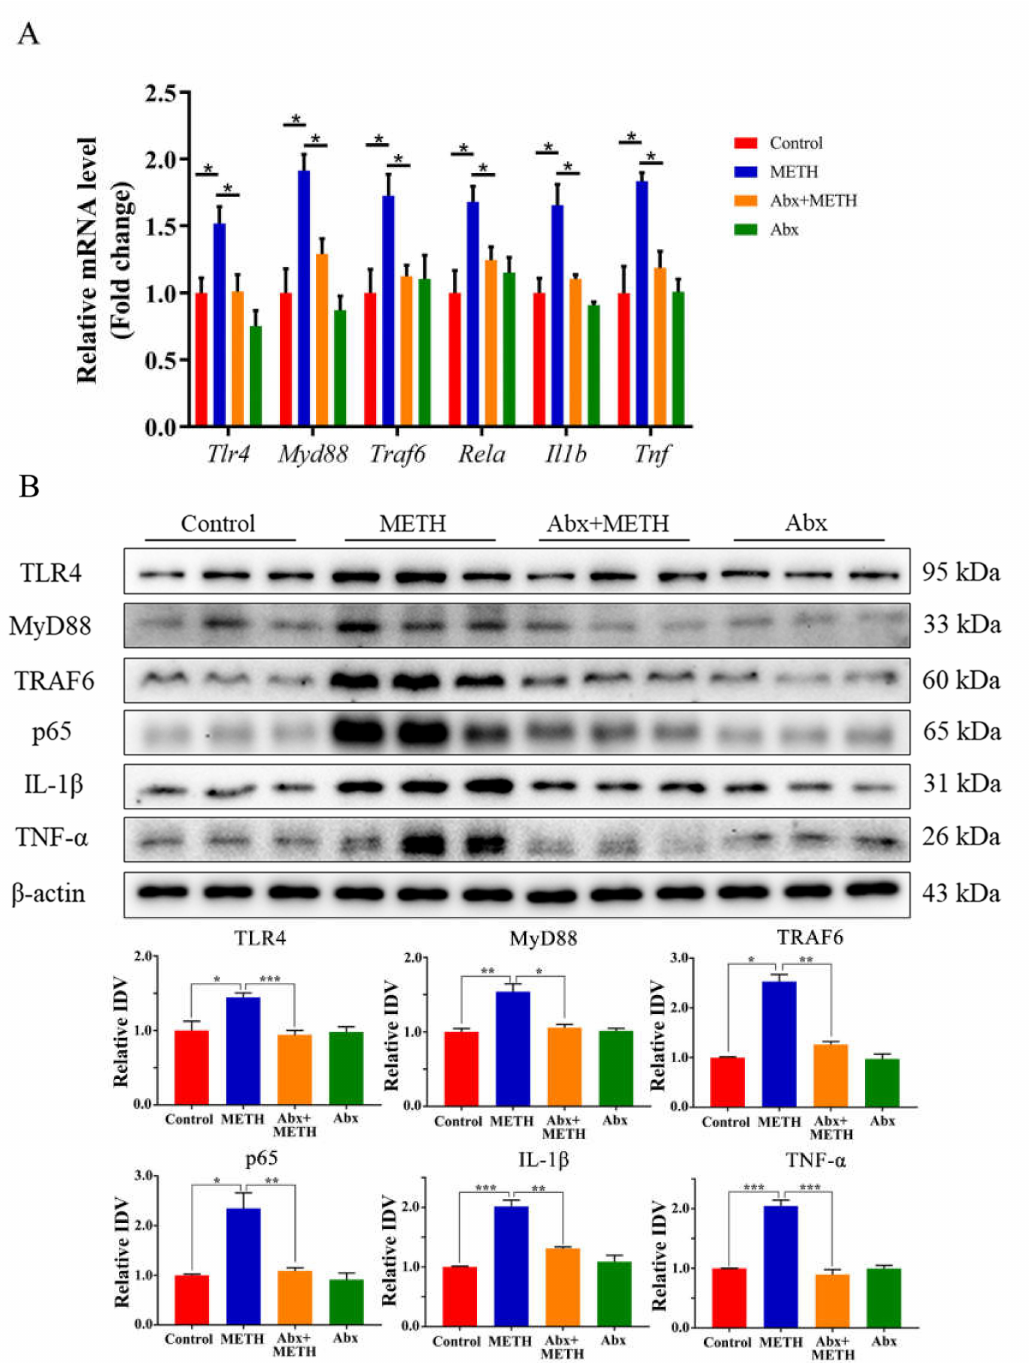
Figure 3. Expression of TLR4, MyD88, TRAF6, p65, IL-1 β , and TNF- α at mRNA and protein levels in mouse liver. ( A ) Relative mRNA expression levels of Tlr4 , Myd88 , Traf6 , Rela , Il1b and Tnf in the mouse liver. METH treatment upregulated the mRNA expression of Tlr4 , Myd88 , Traf6 , Rela , Il1b and Tnf , but antibiotic pretreatment inhibited the effect of METH treatment on the aforementioned mRNAs. ( B ) The expression of TLR4, MyD88, TRAF6, p65, IL-1 β and TNF- α proteins in mouse liver. Abx, antibiotics. * p < 0.05, ** p < 0.01, *** p < 0.001. 2.4. Silencing of the Tlr4 Gene in Mice Significantly Ameliorated METH-Induced Liver Injury Compared to METH-treated wild-type mice, METH-treated Tlr4 − / − mice exhibited alleviated histopathological changes with slightly sparser cytoplasm and normal